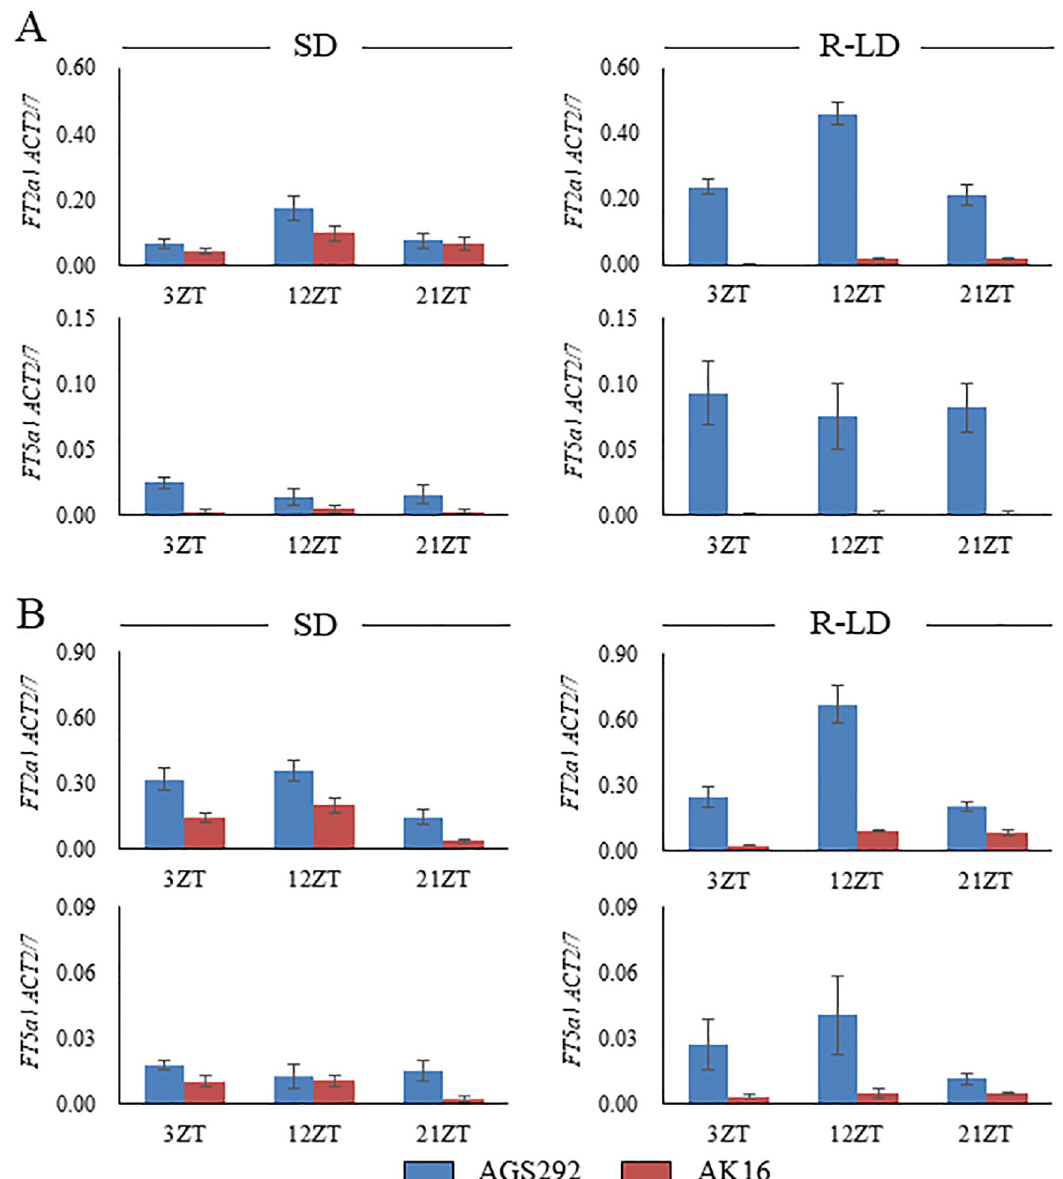
Fig 6. Expression profiles of FT2a and FT5a in soybean lines AGS292 and AK16 under SD and R-LD conditions. (A) Second trifoliate-leaf stage, (B) Fourth trifoliate-leaf